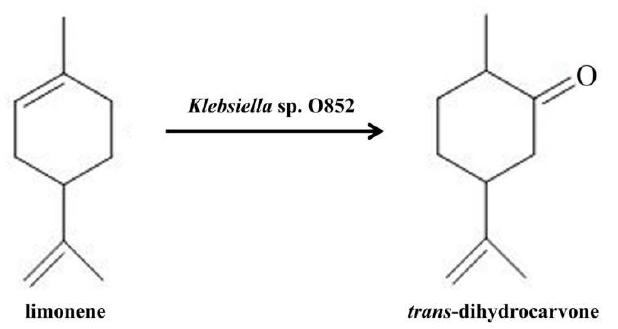
Figure 3. Bioconversion of limonene to trans -dihydrocarvone using Klebsiella sp. O852.